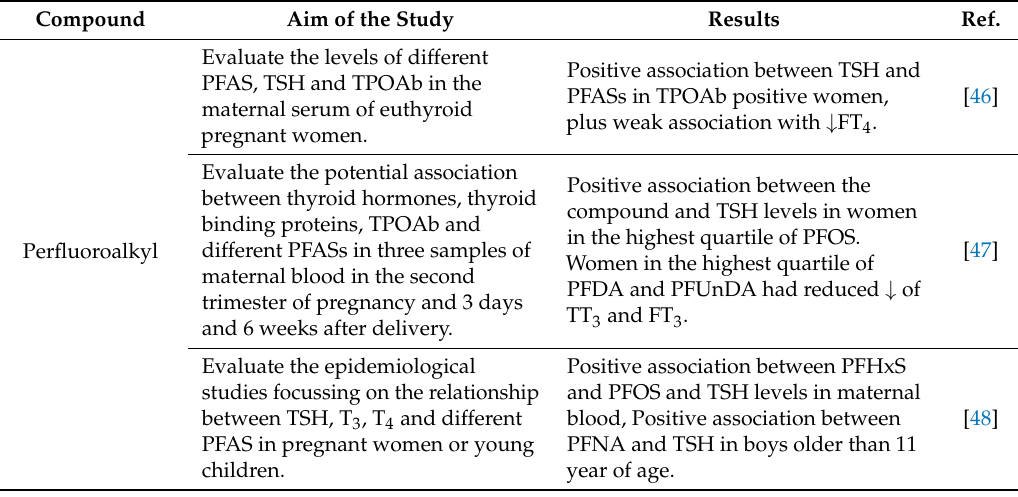
Table 3. Major studies on perfluoroalkyl and main results